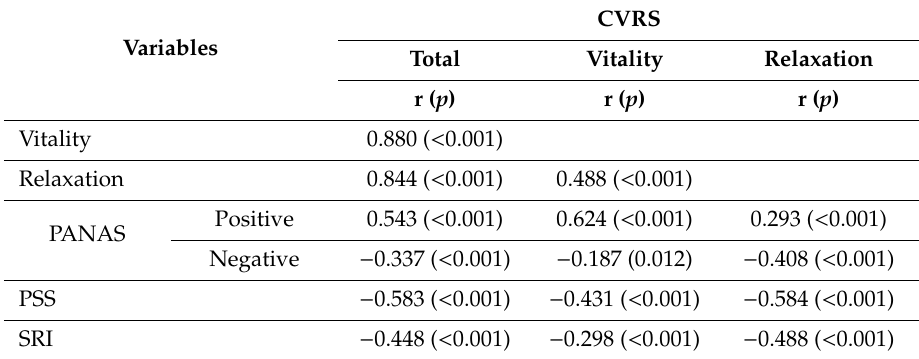
Table 3. Correlations among the CVRS, PANAS, PSS, and SRI.